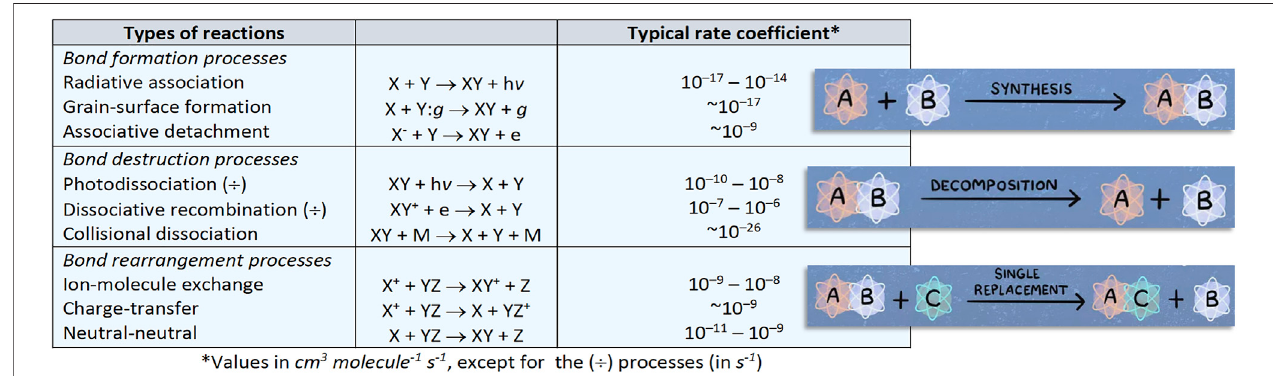
FIGURE 2 | Schematic representation of the reaction types of relevance in astrochemistry together with their typical rate coef fi cients.